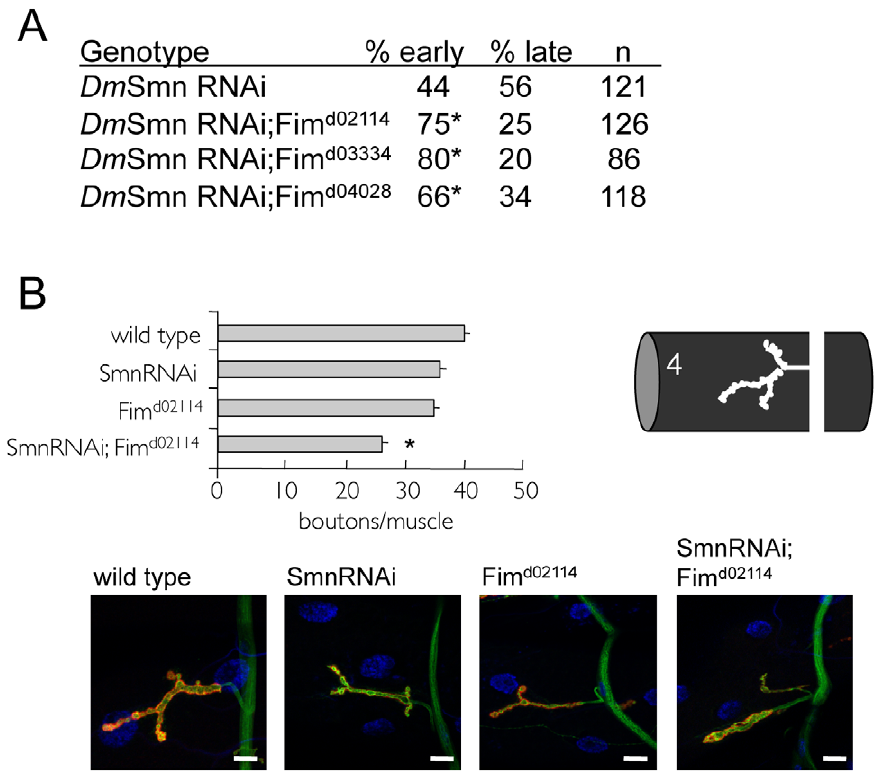
Figure 5. Loss of PLS3 orthologs enhances SMN loss of function defects in invertebrates. Previous studies in vertebrates suggested that PLS3 orthologs in C. elegans and Drosophila might modify SMN loss of function defects [37]. A) A genetic interaction was found between the Drosophila PLS3 ortholog (Fimbrin or Fim) and Dm Smn using previously described Dm Smn RNAi knockdown lines [26] and Fim loss of function alleles. Percentage early or late larval lethality is reported. Ubiquitous RNAi knockdown of Dm Smn using the tubulinGAL4 (TubGAL4) driver results in pupal death; modifier genes alter the percentage of animals that die at early versus late pupal stages (day 7 versus day 9 [26]). Loss of Fim function significantly increased the percentage of animals that died as early pupae (p # 0.05 by Chi-square analysis); Fim is an enhancer of Dm Smn loss of function growth/survival defects. At least 100 animals of each genotype were scored in four replicates for the lethality assay. No significant variation was observed between control and experimental crosses with each independent trial. B) The Drosophila d02114 allele likely eliminates Fim function and in homozygous animals modestly perturbs NMJ morphology at larval muscle 4. Fim d02114 enhances Dm Smn loss of function NMJ defects consistent with studies in vertebrates [37]. All strains carry the ubiquitous TubGAL4 driver. Significance of p # 0.05 versus single mutant strains was determined by ANOVA and is indicated with asterisk; S.E.M. is shown. In representative images, red corresponds to anti-Discs Large (DLG), green is anti-synaptotagmin and blue is DAPI; scale bar indicates 15